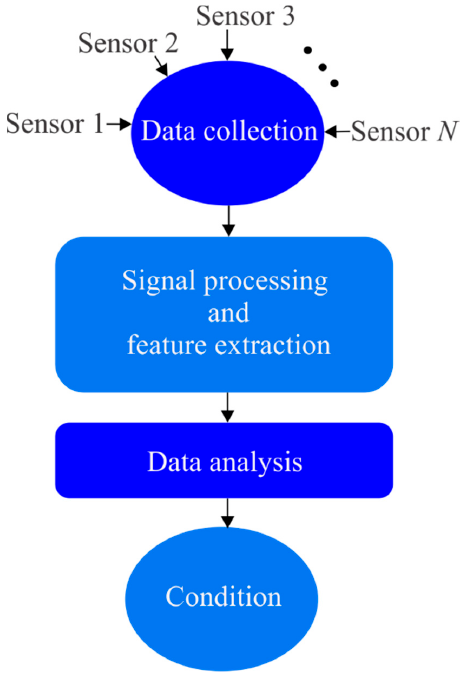
Figure 1. General elements of a condition monitoring strategy.